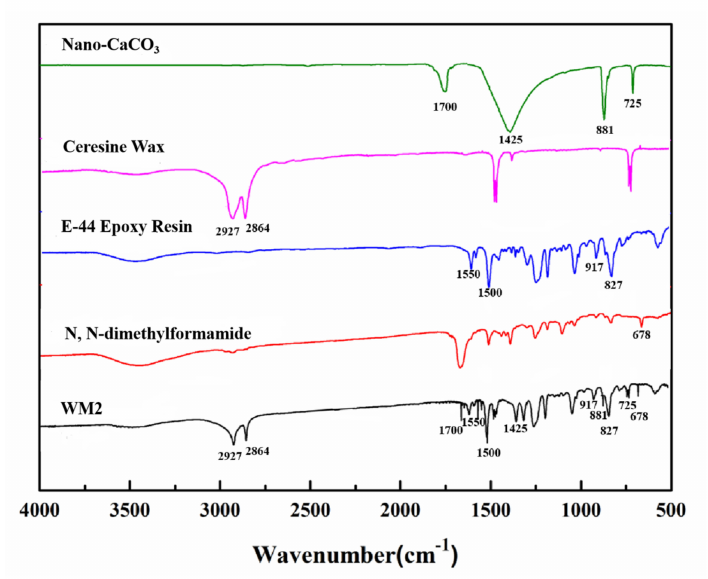
Figure 6. FTIR spectra of nano-CaCO3, ceresine wax, E-44 epoxy resin, N, N-dimethylformamide and WM2.